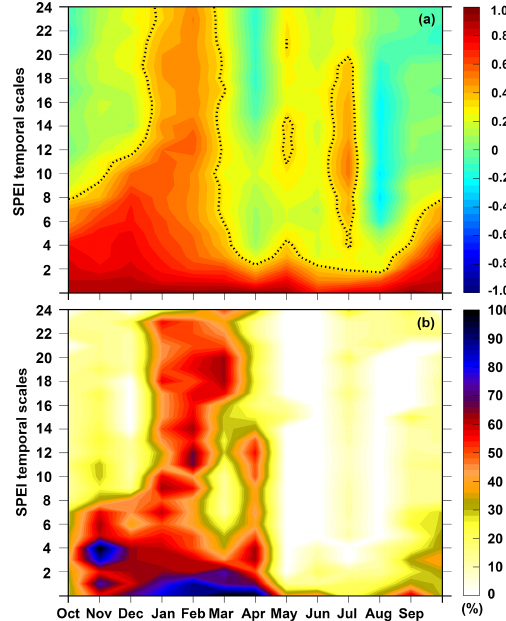
Figure 18. (a) Monthly correlations among the SRI1 for the en- tire Miño–Limia–Sil hydrographic demarcation (MLSHD) with the SPEI1 to the SPEI24 in the MLSHD; values within dotted lines rep- resent significant correlations at p < 0 . 05. (b) Rate (in percentage) of hydrological drought (SRI1 ≤− 0 . 84) during drought conditions according to the monthly SPEI1 ≤− 0 . 84. Period of